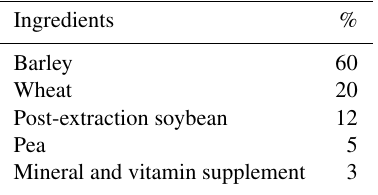
Table 3. Proximate composition and fatty acid profiles (%) of the pig